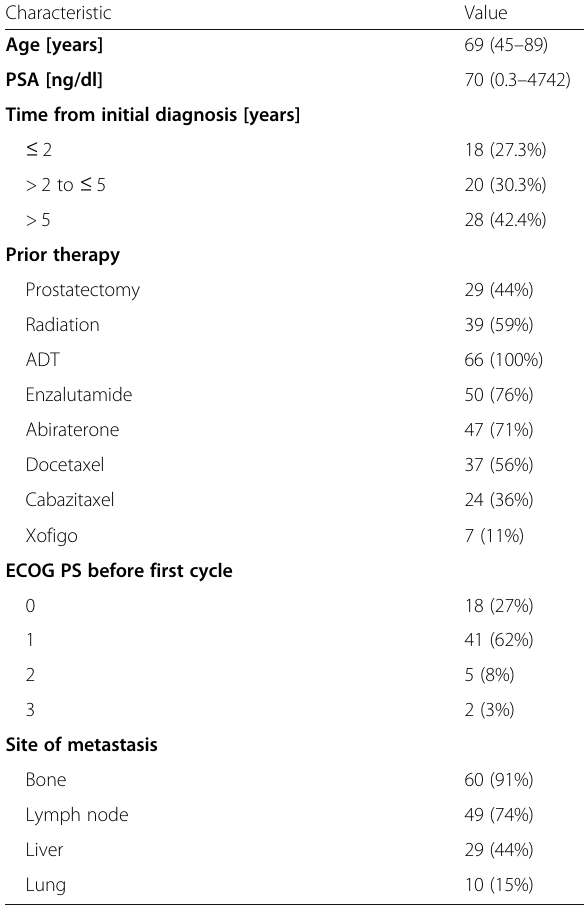
Table 1 Patient